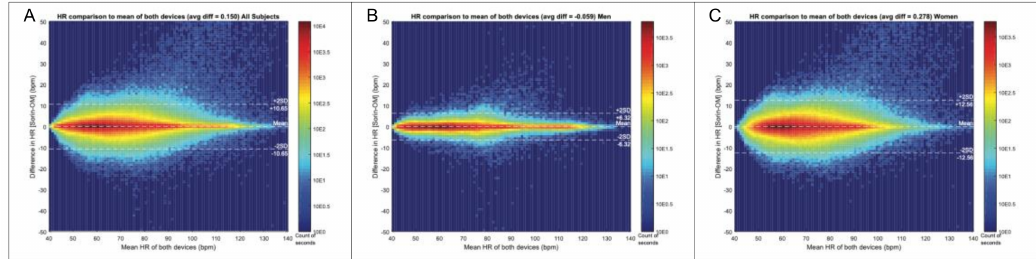
Figure 4. Bland-Altman analysis for signal coverage. ( A ) The overall signal coverage by the OMgarment was excellent, showing an almost perfect overlay compared to standard Holter recording with a mean difference in heart rate of only 2 ± 5 bpm. The quality of signal coverage with OMgarments showed no difference between women ( B ) and men ( C ) and was equivalent to Holter